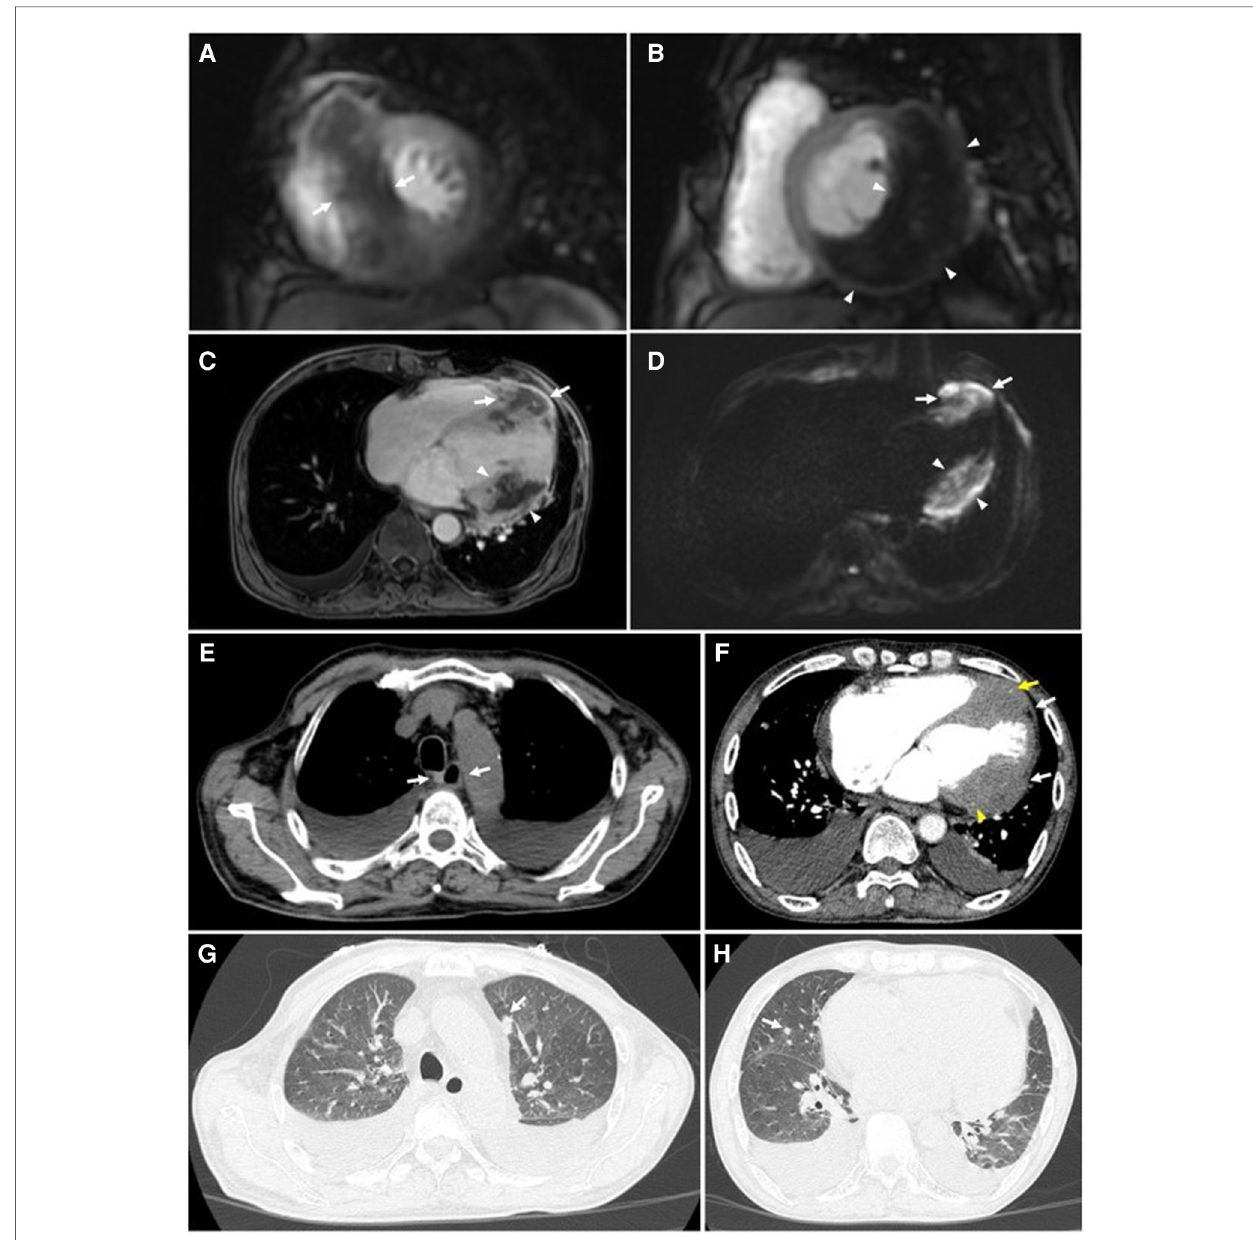
FIGURE 3 Cardiac magnetic resonance and thoracic computed tomography were obtained 6 months after completion of chemoradiotherapy. CMR: ( A to D) Tumors of the interventricular septum (white arrows) and inferior-lateral left ventricular wall (white arrowheads) do not demonstrate enhancement on short-axis fi rst-pass perfusion images ( A & B ) and axial post-contrast T1-weighted images ( C ) suggestive of necrosis. These lesions demonstrate restricted diffusion on the axial diffusion-weighted images (DWI) ( D) . ( E) No abnormal thickening of the esophageal wall is seen on the mediastinal window (white arrows). ( F) Tumors of the interventricular septum and inferior-lateral left ventricular wall invade the left anterior descending (LAD) artery (yellow arrows) and left circum fl ex (LCx) artery (yellow arrowheads) , respectively. These lesions also extend to the pericardium (white arrows). ( G & H) Metastatic nodules in the upper lobe of the left lung and the middle lobe of the right lung are seen on the lung window (white arrows)